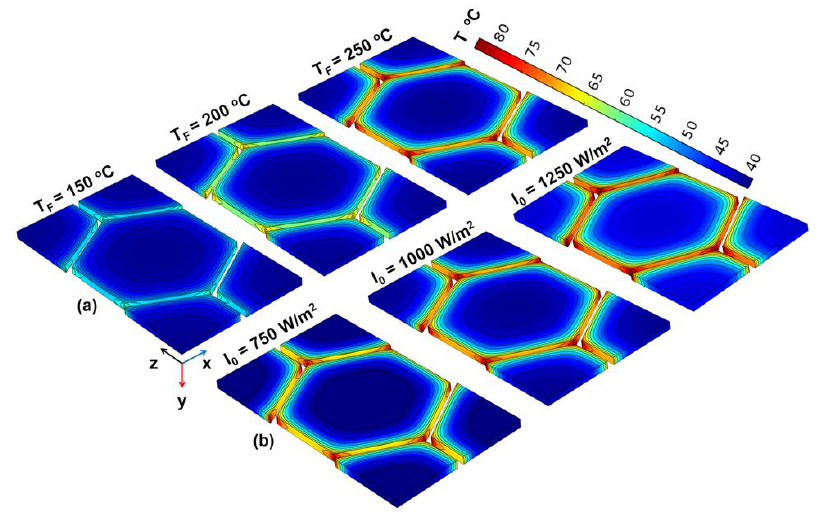
Figure 2. Contours of waveguide temperature for different: ( a ) heat transfer fluid (HTF) temperatures and ( b ) incident solar